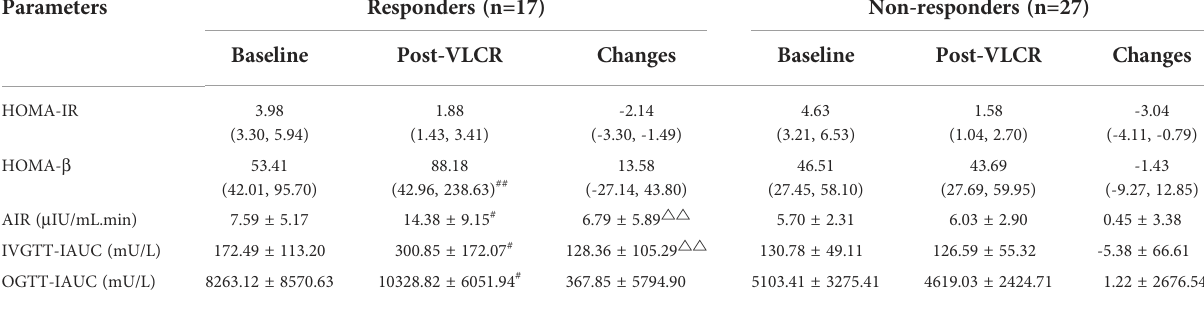
TABLE 4 Parameters of b -cell function and insulin sensitivity before and after VLCR in responders and non-responders.